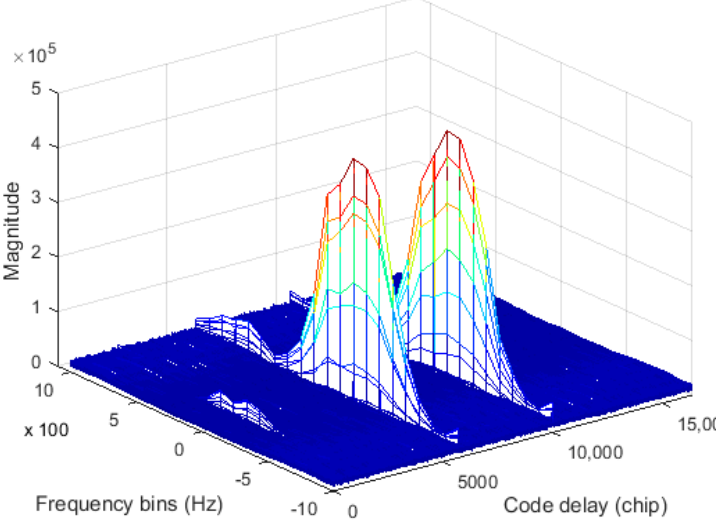
Figure 16. The equipment of MDBBS.